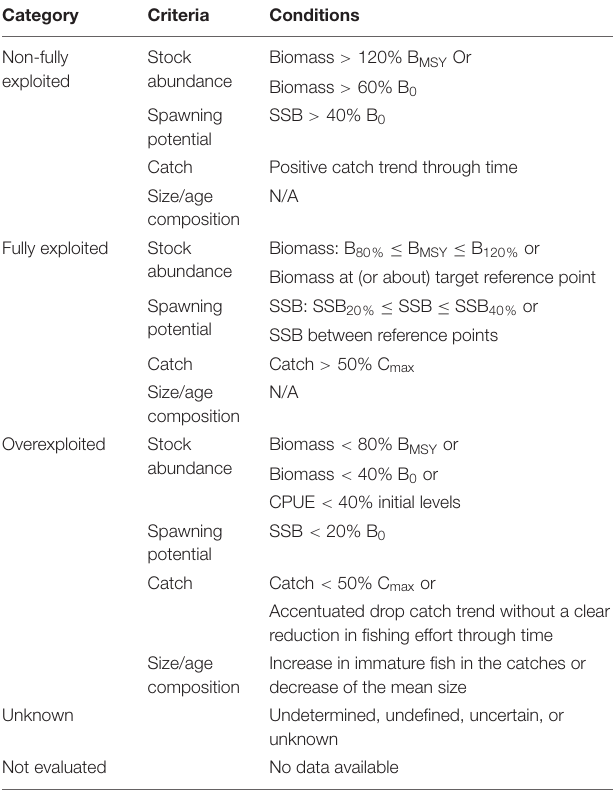
TABLE 1 | Biomass stock status categories and criteria, with respective conditions, used in this study to classify the biomass status of snapper and grouper stocks/fisheries (adapted from the FAO classification (Ye,